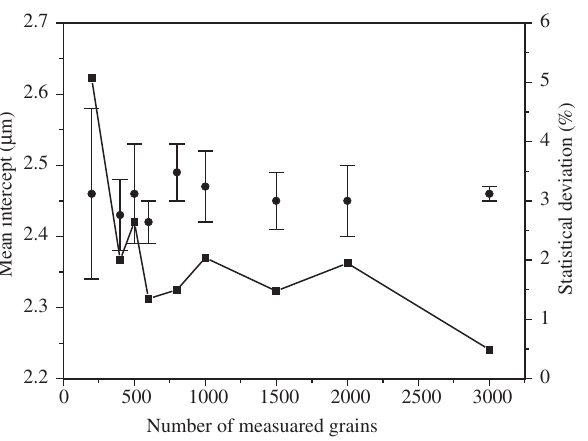
Figure 5. Population of triangular, quadrilateral and pentagonal cut sections and the statistical deviation pattern vs. the number of measured